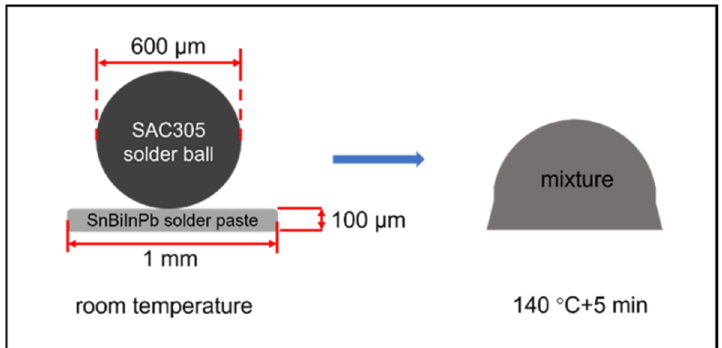
Figure 1. Schematic diagram of the assembly process using SAC305 solder balls and 13.5Sn-37.5Bi- 45In-4Pb solder paste.